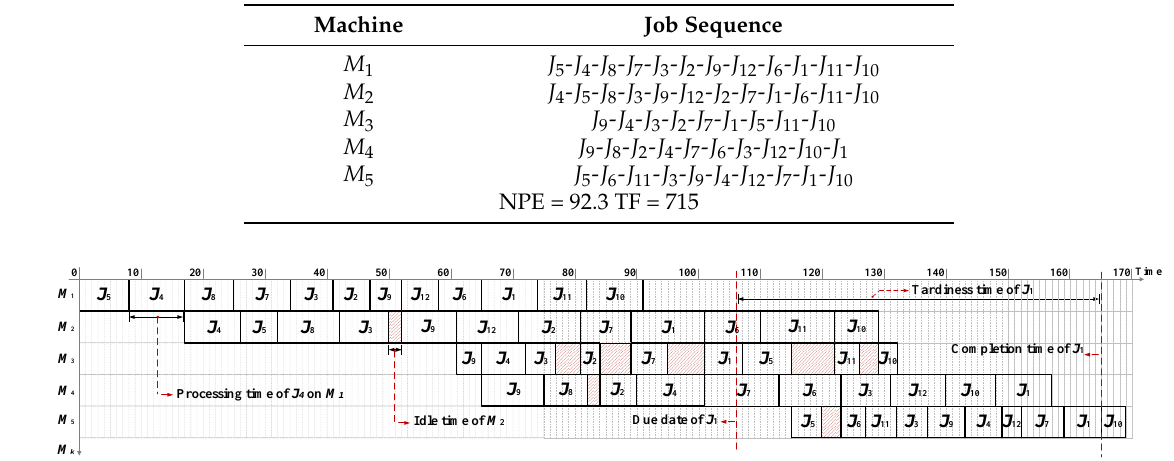
Table 4. The job sequences, NPE and TF, of the example solution.